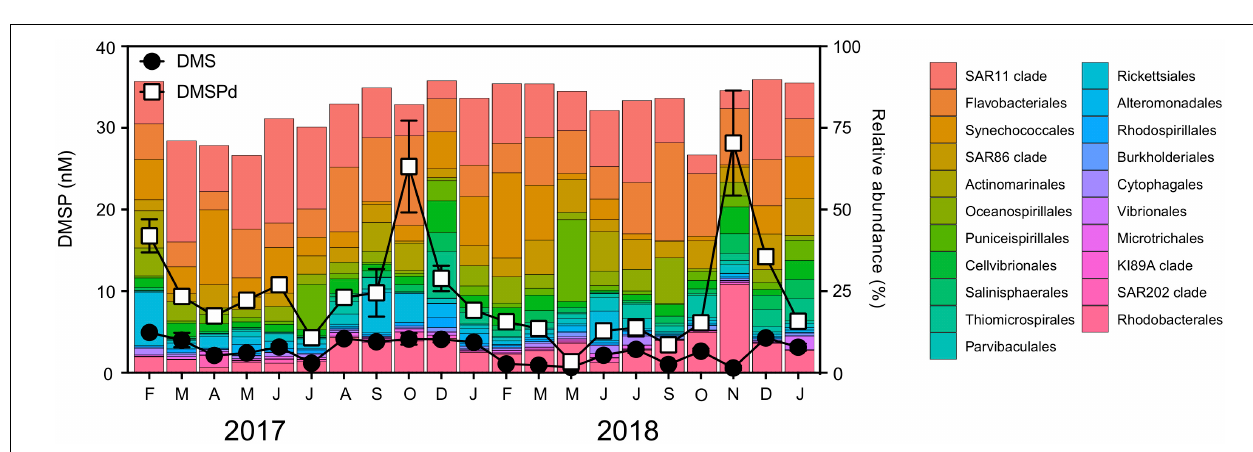
FIGURE 5 | Relative abundance of the bacterial community at Port Hacking NRS between February 2017 and January 2019. Line scatter plots show nM concentrations of dissolved DMSP (DMSPd) and dimethyl sulfide (DMS) measured during the time series. DMS (P) data are means ± standard error ( n =